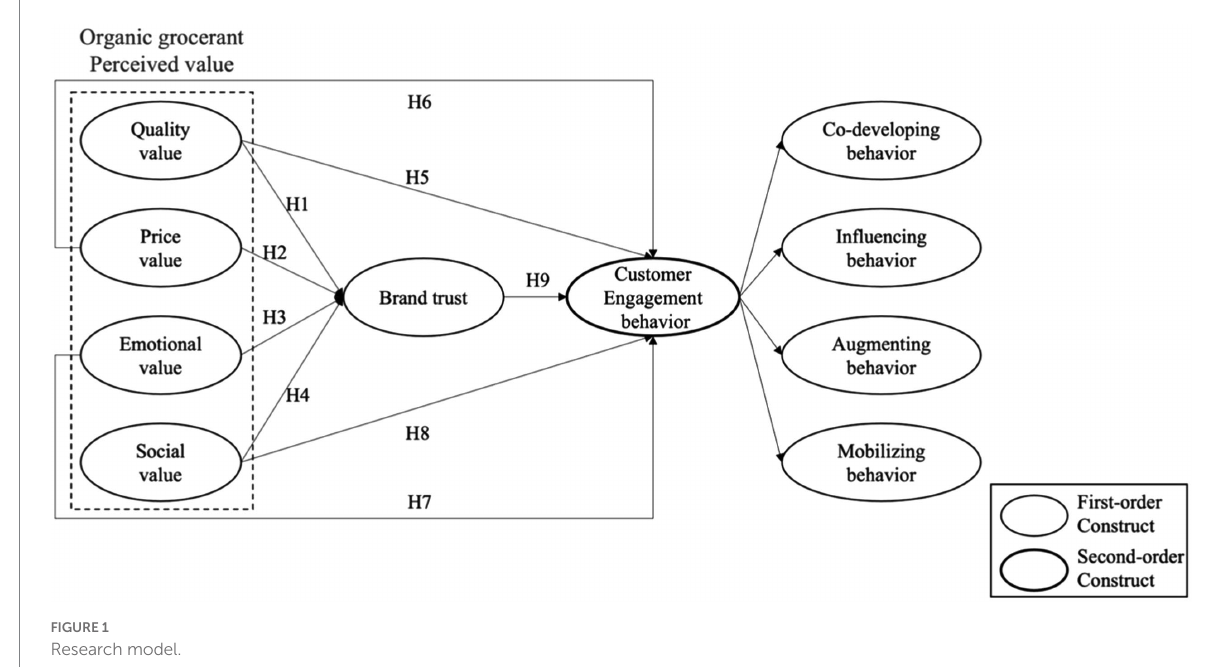
FIGURE 1 Research